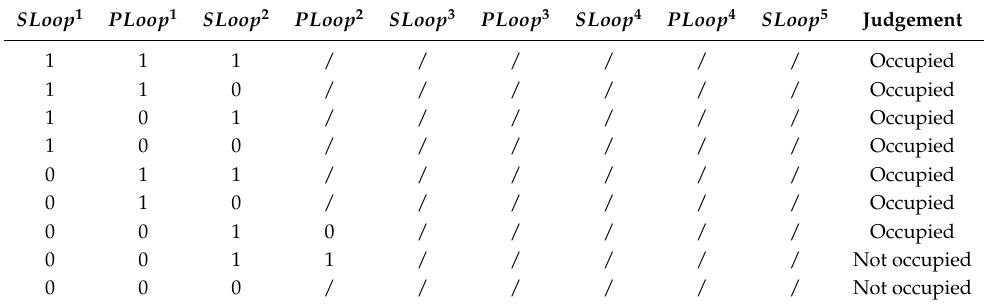
Table 2. Judgement of whether Lane 1 is occupied.